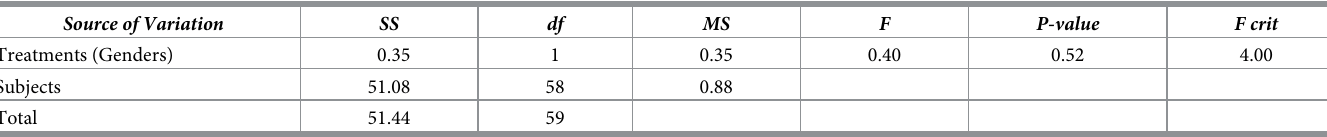
Table 14. One-way ANOVA—Viewpoint